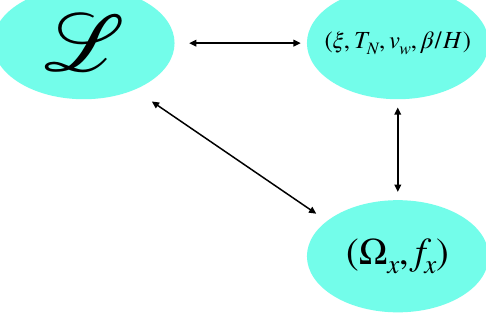
Figure 2 . (Schematically) the LISA inverse problem . In the above, the subscript x refers to the dominant peak of the GW spectra (collision, sound wave, or turbulence). As described in the text, for most models the sound wave contribution is dominant. The thermal parameters of the PT can be calculated by solving the bounce EOM (4.1), and then related to the GW spectra using (4.7) and (4.11). This paper (cid:12)nds general relations between the GW spectra and the